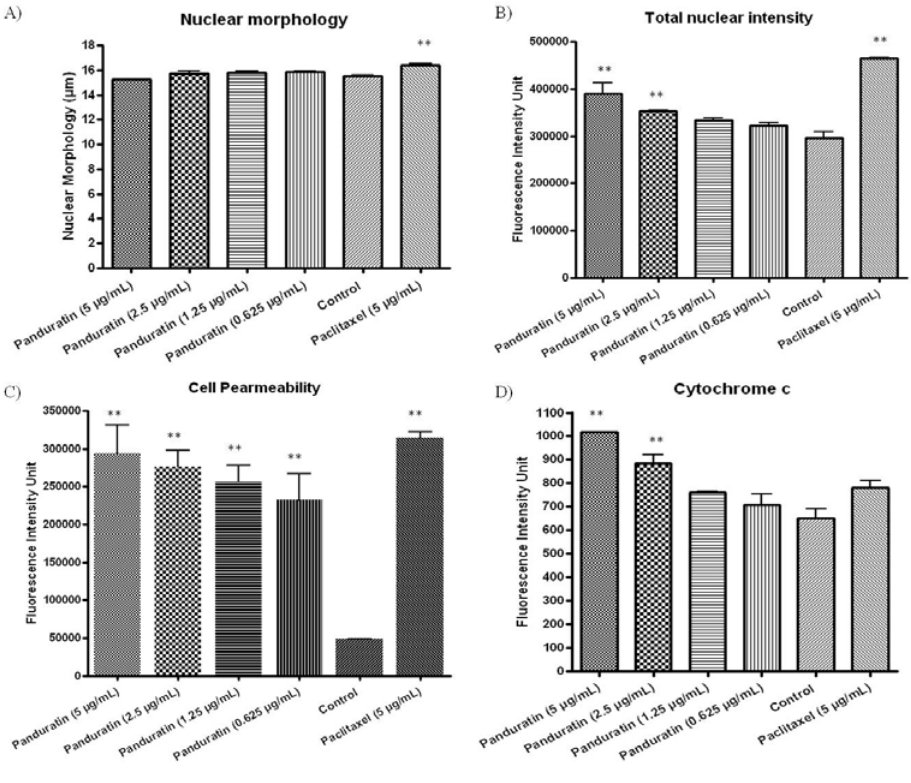
Figure 7. Changes in A) nuclear size and morphology, B) DNA content, C) cell permeability and D) cytochrome c localization were all measured simultaneously in A549 cells. Following treatment with panduratin A, we saw statistically significant cell loss